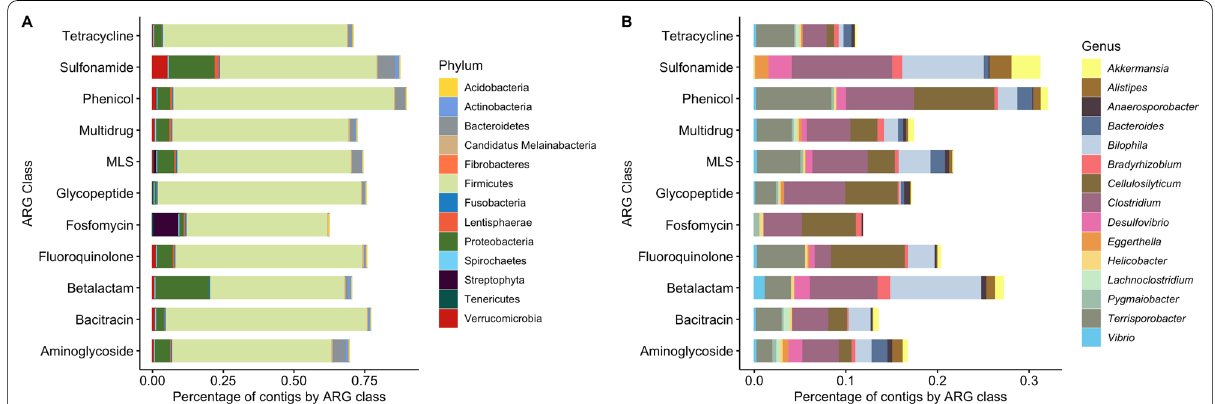
Fig. 8 Proportion taxa associated with contigs carrying ARGs (ACCs). A Phyla associated with ACCs. B Top 15 bacterial genera associated with